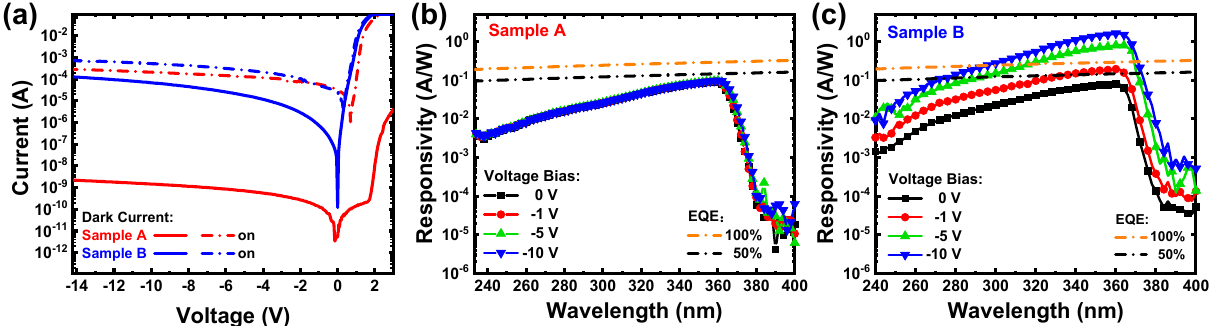
Figure 4. ( a ) I-V curves of samples A and B measured in dark; the spectral response curves of samples ( b ) A and ( c ) B under various reverse biases.